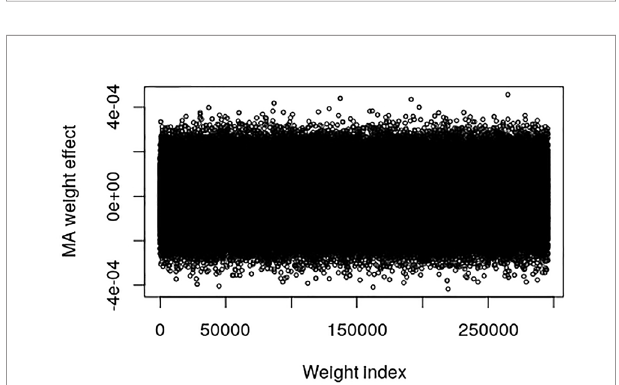
FIGURE 2 | Plot of model averaged weight effects against weight index in the output layer when breeding values (EBVs) of the Austrian pig data are used